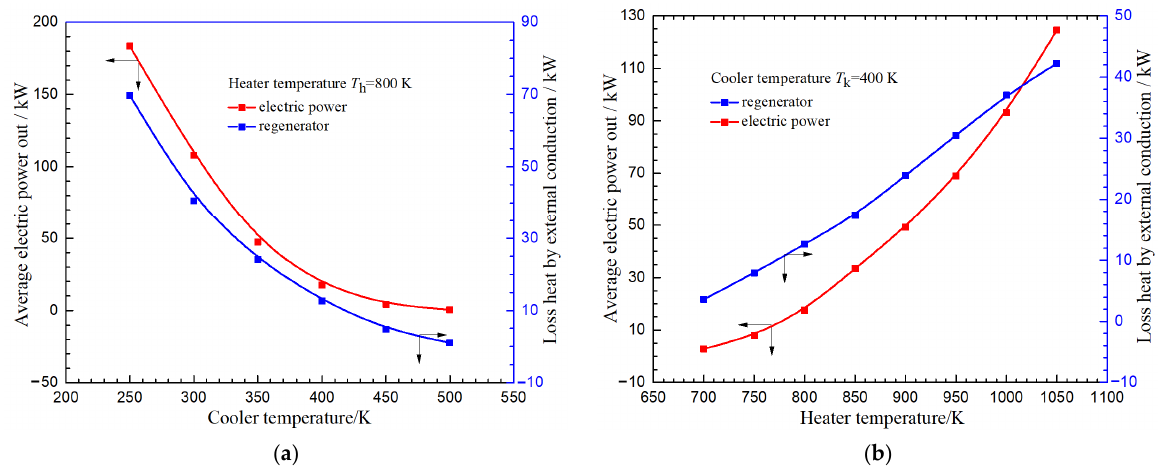
Figure 16. The effect on power and energy loss: ( a ) effect of cooler temperature, ( b ) effect of heater temperature.